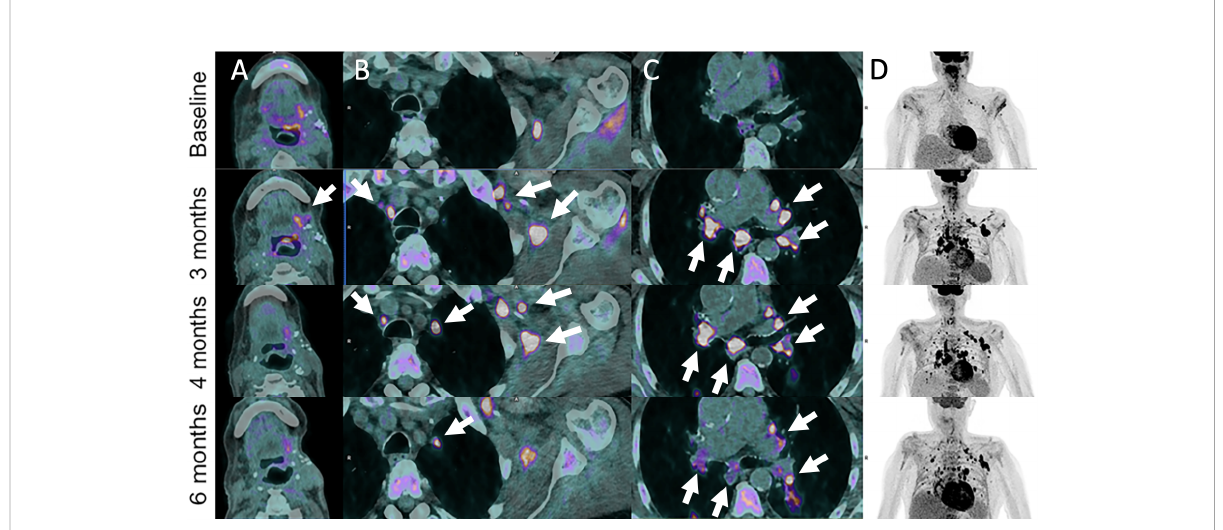
FIGURE 2 Pseudoprogression in 72-year-old male patient with left base of tongue squamous cell carcinoma recurrence after initial surgery with satellite cervical, axilla and mediastinal lymphadenopathies as shown on 18 F-FDG-PET/CT images (Baseline, A – D ). Pembrolizumab (anti-PD-1) was administered. Follow-up imaging at 3 months post-pembrolizumab administration shows local increase in metabolism together with hypermetabolic left axillar and symmetrical mediastinal and hilar lymph node enlargement (sarcoidosis-like reaction) (arrows). These features progressively disappeared or markedly improved at 4- and 6-months follow-up.